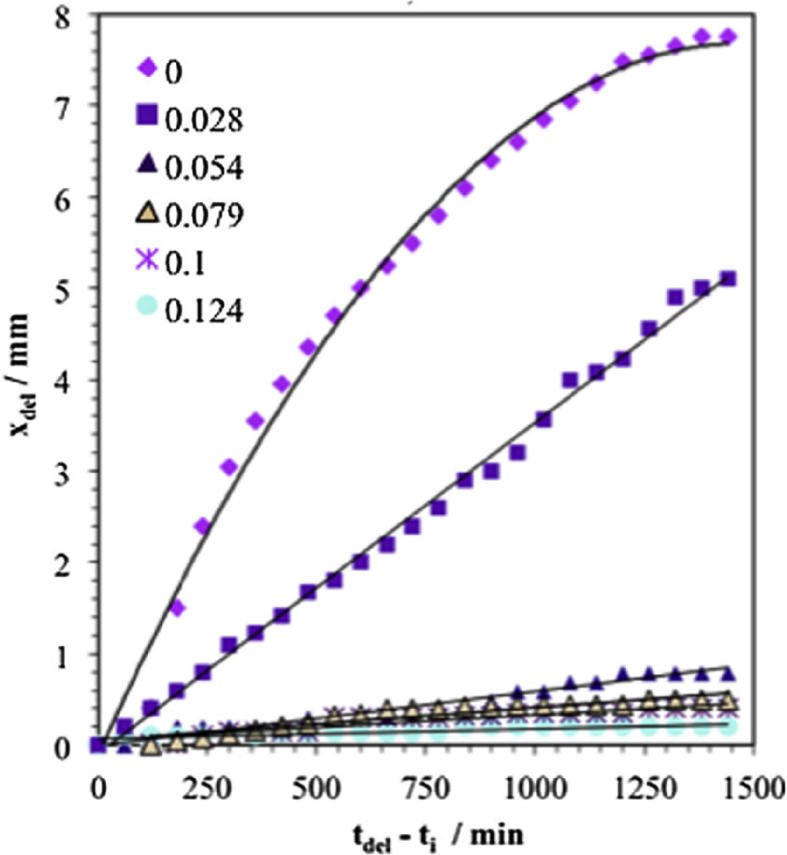
Plots of delamination distance with time for PVB coatings containing different pigment volume fractions of GNP (shown in legend). From Glover et al. [2017].30